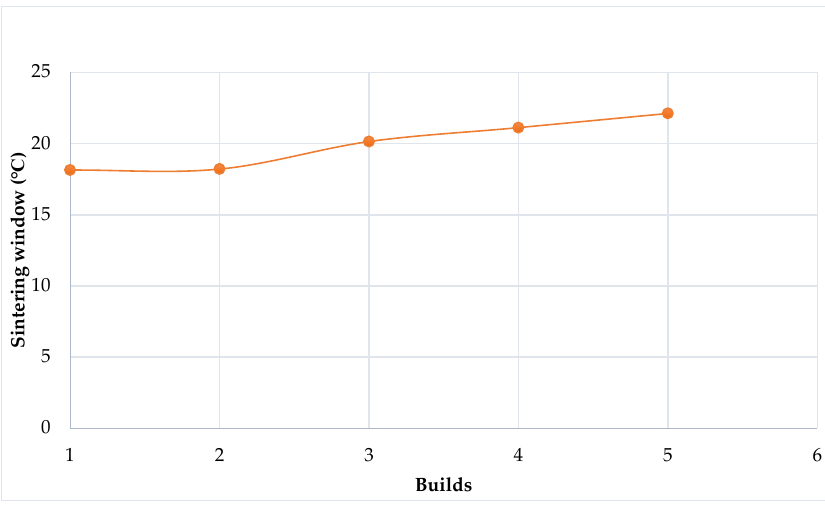
Figure 12. Sintering window of Laser PP CP 75 versus re ‐ use cycles.